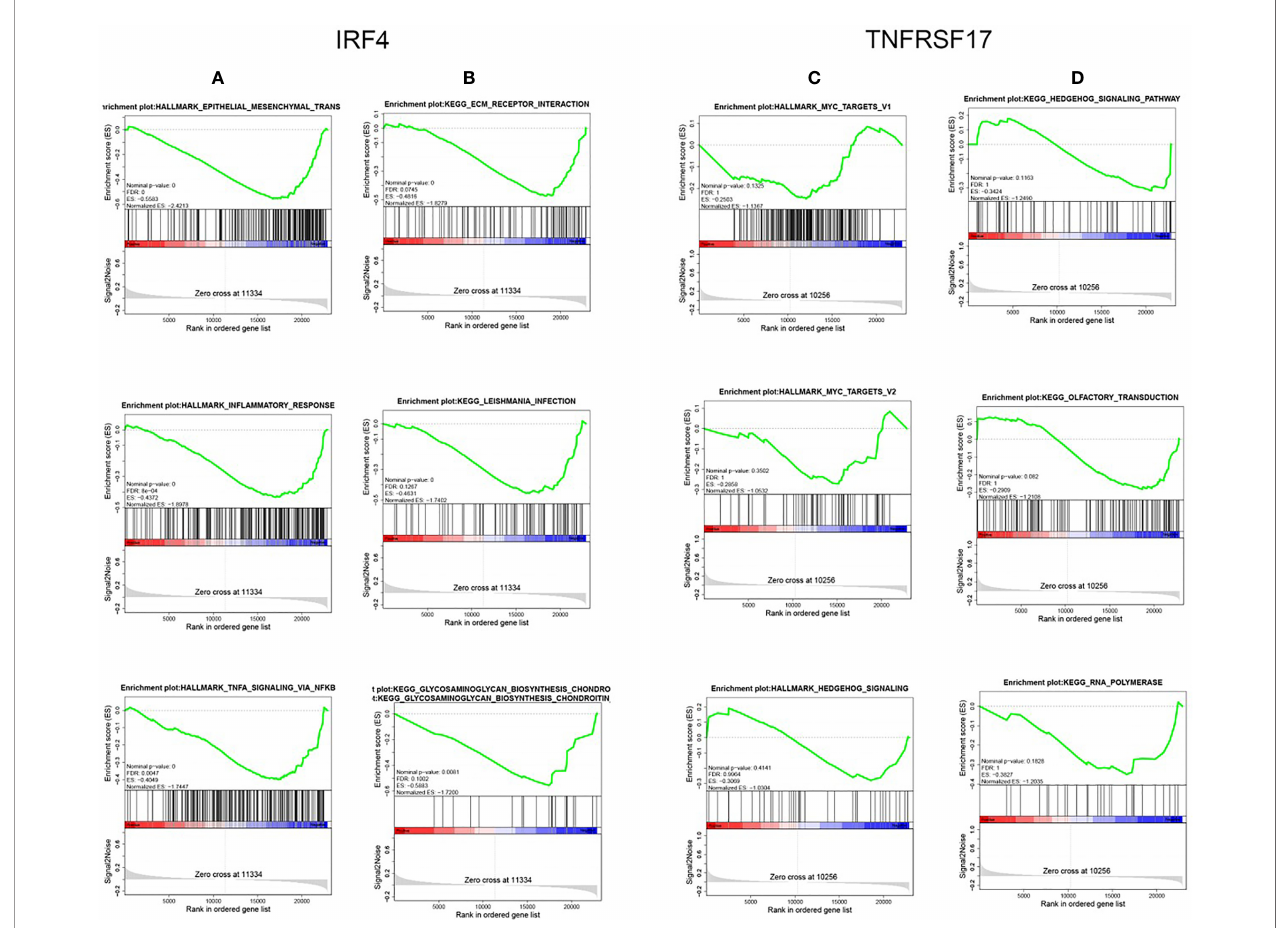
FIGURE 9 | GSEA. Top 3 Hallmark and KEGG pathways of IRF4 and TNFRSF17, respectively. (A, C) are Hallmark pathways, and (B, D) are KEGG